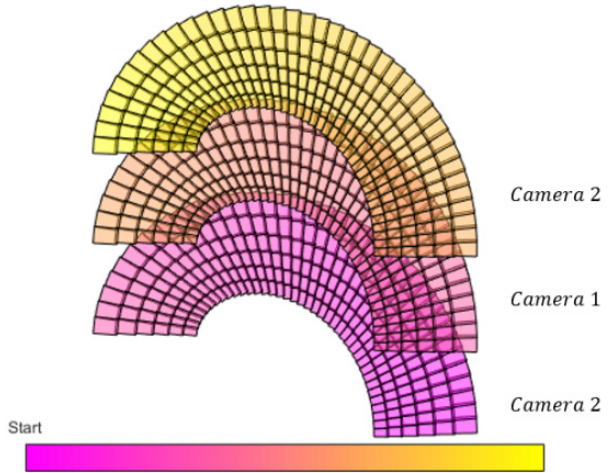
Figure 17. Dual-camera variable Speed OCPSI Mode ground overlay schematic diagram: improve- ment.